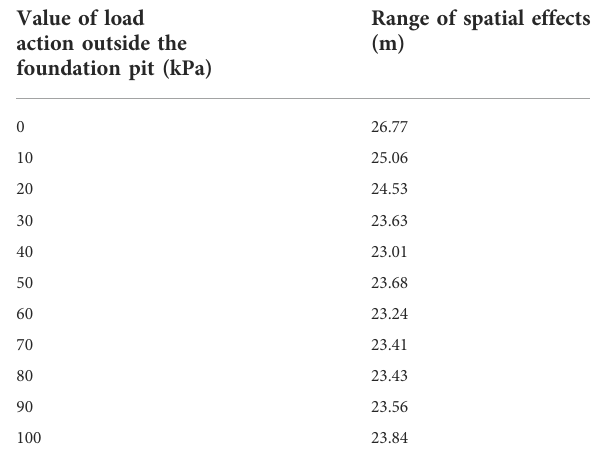
TABLE 3 Range of spatial effects under symmetric